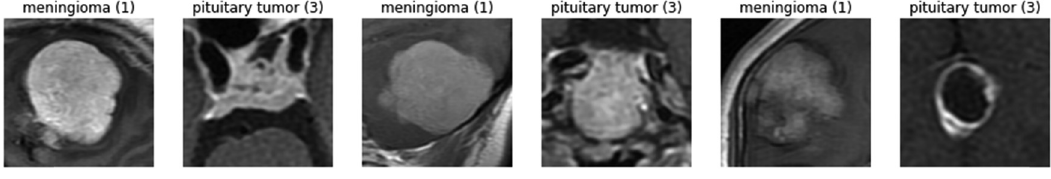
Figure 5: Cropped